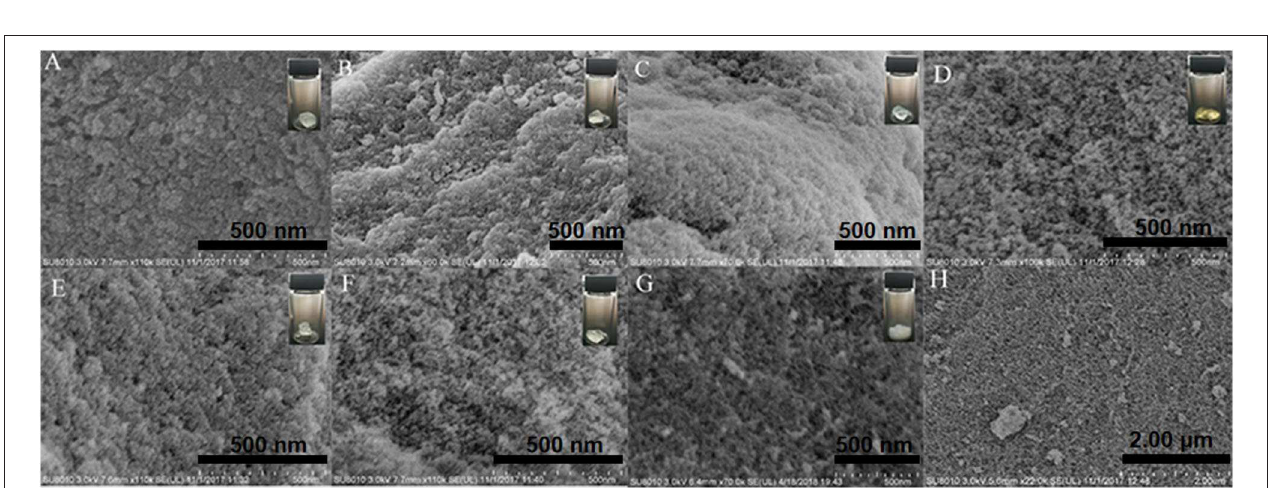
FIGURE 1 | FE-SEM analysis of composite SAs soaked with different reagents: (A) S1 (Ni 2 + ), (B) S2 (Ba 2 + ), (C) S3 (Cu 2 + ), (D) S4 (Fe 3 + ), (E) S5 (Ca 2 + ), (F) S6 (Mg 2 + ), and (G,H) S7